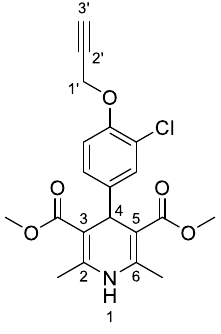
Figure 8. Chemical stucture of 3g .